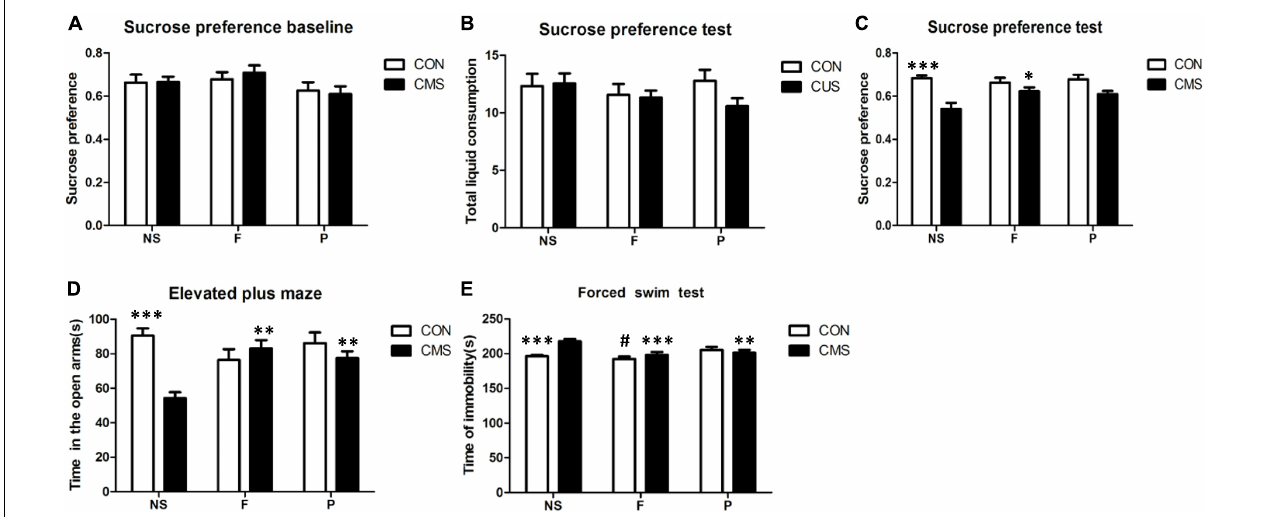
FIGURE 2 | Behavioral assessments in mice. (A) There were no differences among six groups in sucrose preference at baseline before exposure to the CUS protocol. (B) SPT results showed no significant differences in total liquid consumption. (C) Sucrose preference was significantly decreased after 4 weeks of CMS, and this effect of stress was reversed by fluoxetine, but not by probiotics. (D) EPM test results showed that the time spent in the open arms was significantly reduced in the CMS group, and this effect of stress was reversed by fluoxetine and probiotics. (E) Results of FST showed that the immobility time was significantly increased in the CMS group; the change of immobility time induced by CMS was reversed by fluoxetine administration or probiotics administration. The comparision of three groups without CMS revealed that fluoxetine administration led a significantly decreased in the immobility time compared with probiotics administration. Data are presented as mean ± SEM; n = 8 per group; ∗ P < 0.05, ∗∗ P < 0.01, ∗∗∗ P < 0.001 vs. the CMS + NS group, # P < 0.05 vs. the CON + P group. SPT, sucrose preference test; EPM, elevated plus maze; FST, forced swim test; CMS + NS, subjected to the CMS procedure and received saline; CMS + F, subjected to the CMS procedure and received fluoxetine; CMS + P, subjected to the CMS procedure and received probiotics; CON + NS, not subjected to any stress and received saline; CON + F, not subjected to any stress and received fluoxetine; and CON + P, not subjected to any stress and received